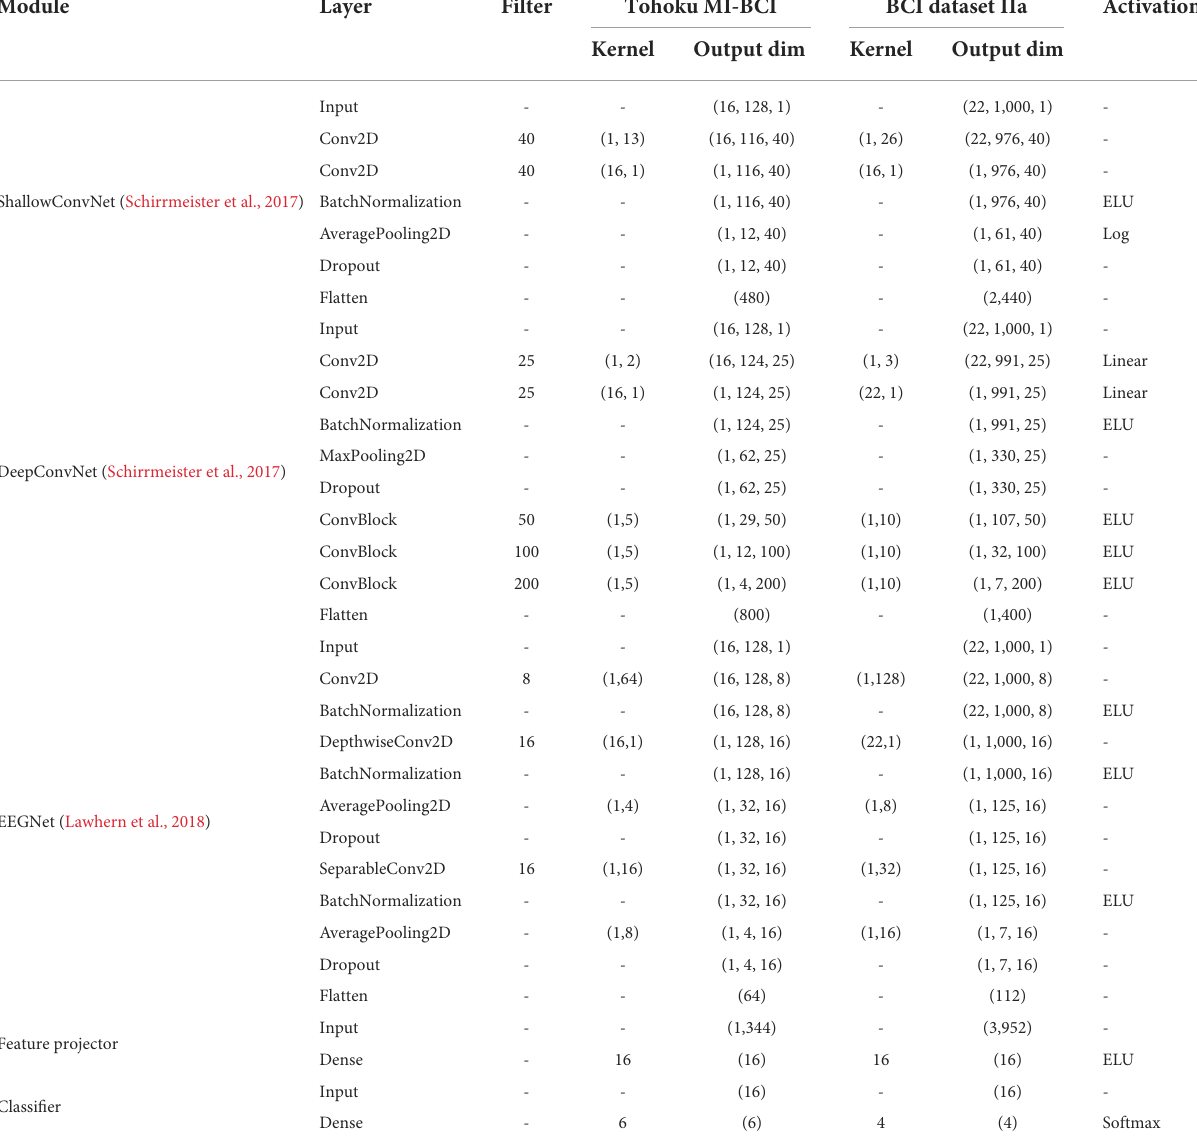
TABLE 1 Architecture and parameters of each module, and ELU is exponential linear unit.